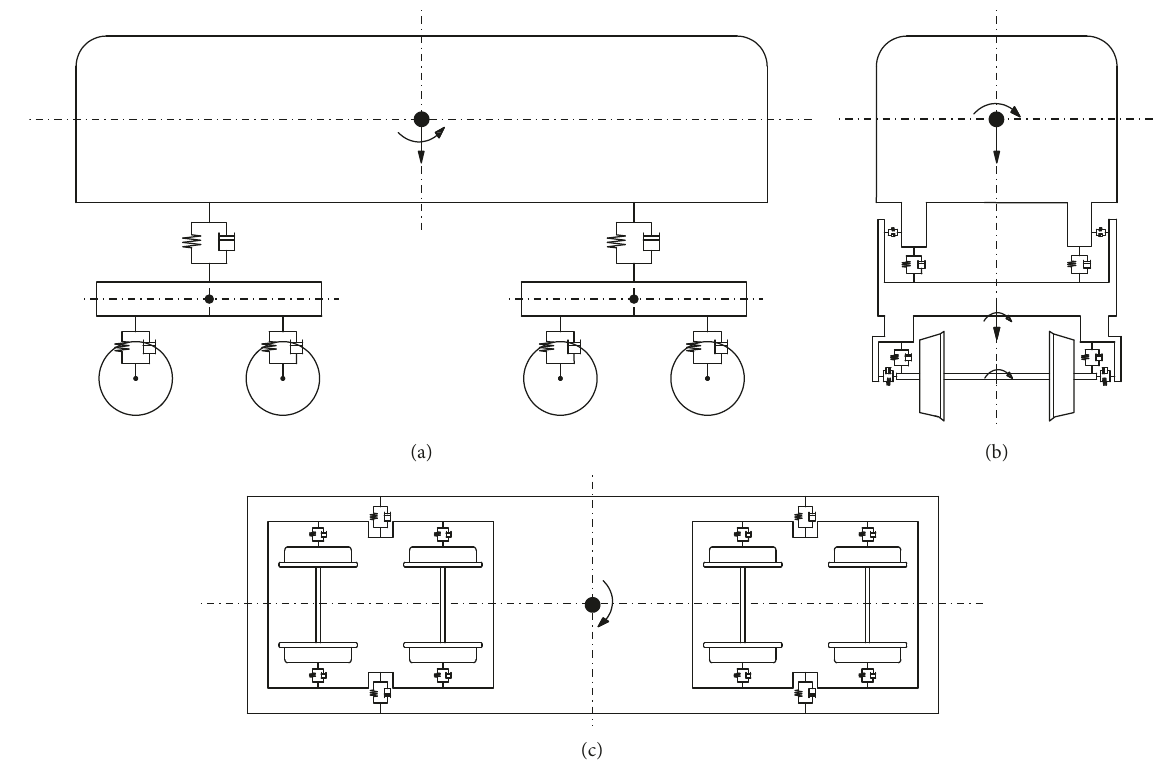
Figure 1: Vehicle model. (a) Front view. (b) Left view. (c) Bottom view.